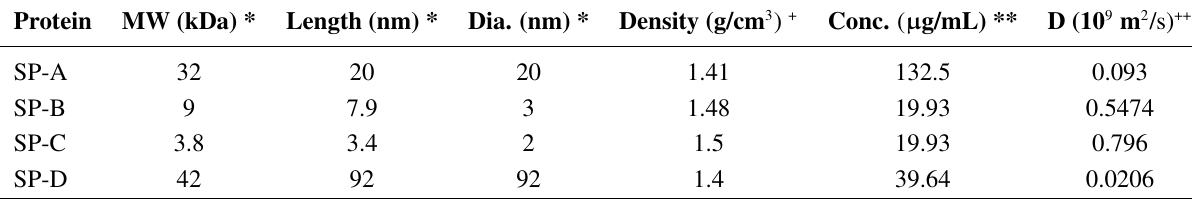
Table 3. Properties of surfactant